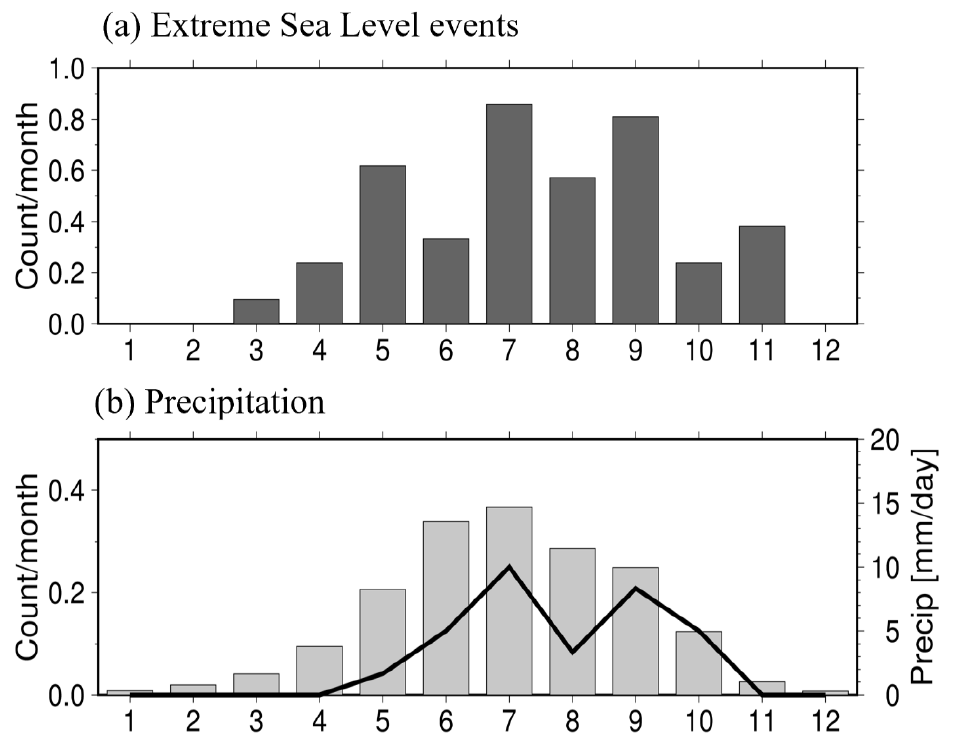
Figure 9. ( a ) Monthly variation of ESL events at Cox’s Bazar (count per month) averaged during 1983–2006. Note that the years of 2001–2003 were excluded due to data unavailability. ( b ) Monthly variations of mean precipitation (mm/day; bar) during 1983–2006, averaged over the Bangladesh area (20° – 27° N and 87.7° – 93° E), and the number of days exceeding 50 mm/day of the area-mean precipitation (count per month; line).